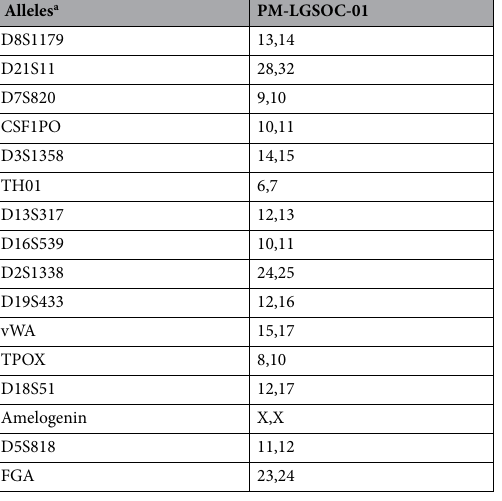
Table 1. STR profile for the PM-LGSOC-01 cell line. a A detailed description of each allele is presented at the following link: